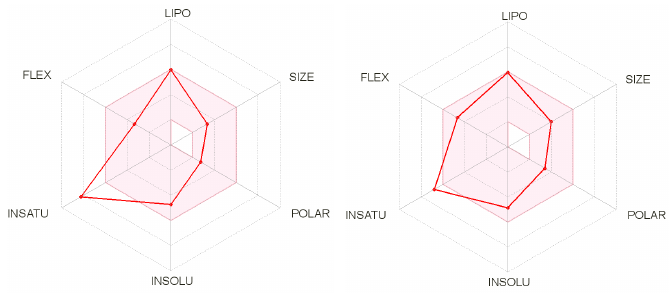
Figure 2. Bioavailability radar for drug-likeness using the SwissADME tool to magnolol (left) and biseugenol (right) demonstrating better adherence of biseugenol to different physicochemical descriptors. The red area represents the optimal range for each property.vb.